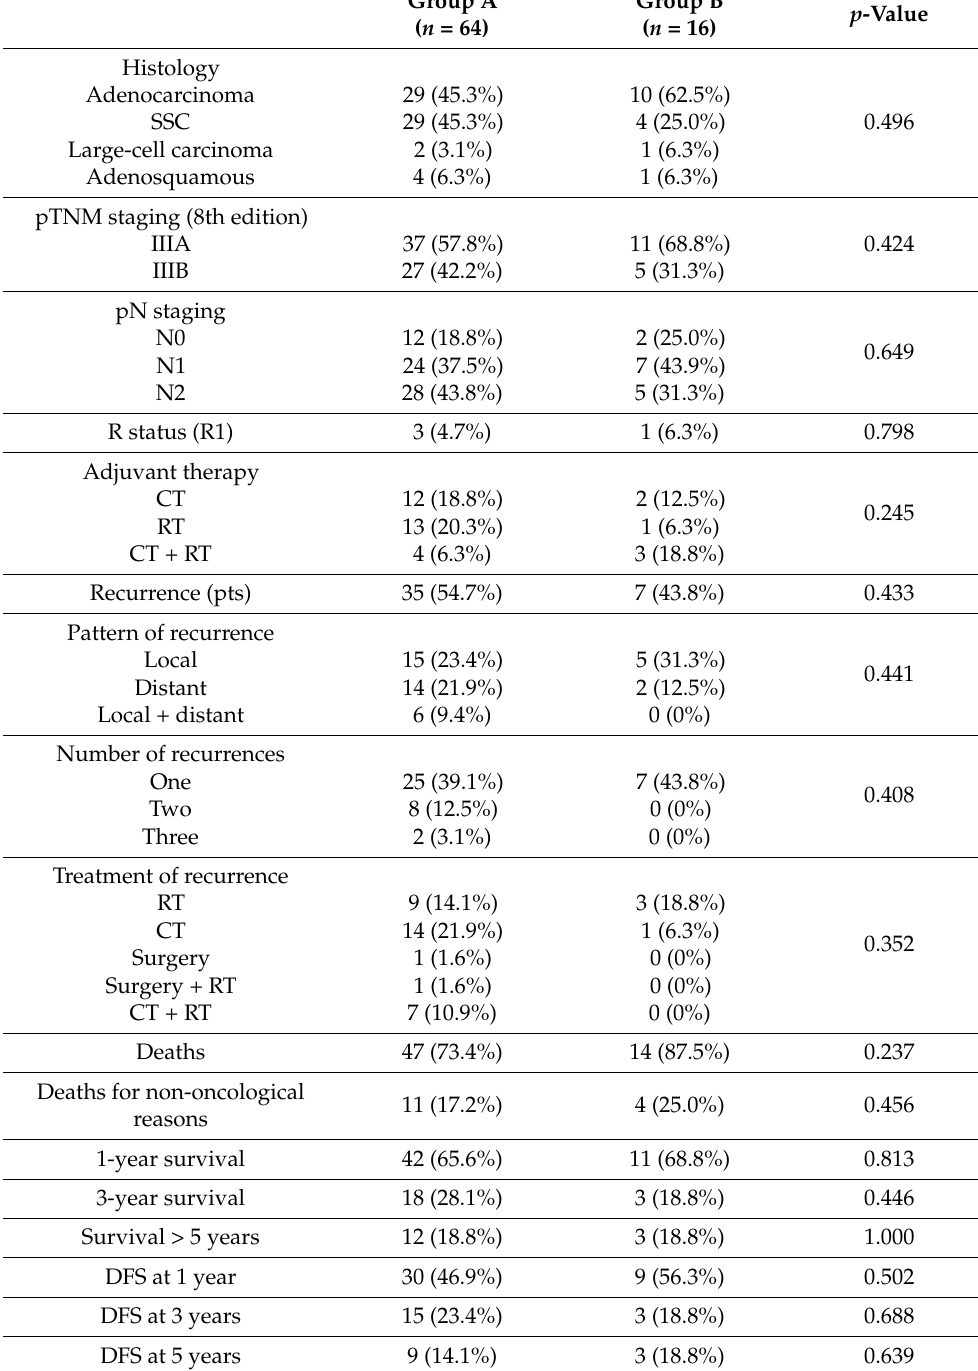
Table 3. Histological and oncological